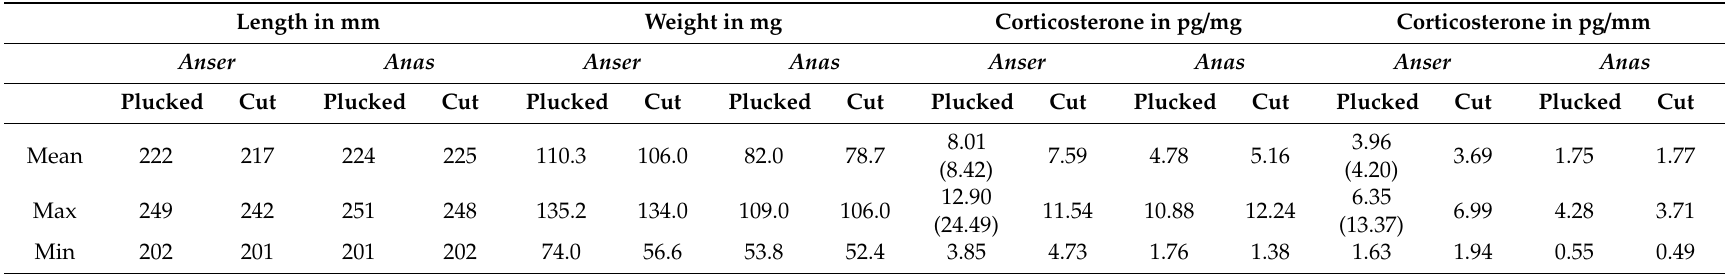
Table 2. Overview of the measured results of 40 geese and 37 ducks in length, weight and corticosterone levels; the contaminated samples were excluded. The values in brackets are those including the